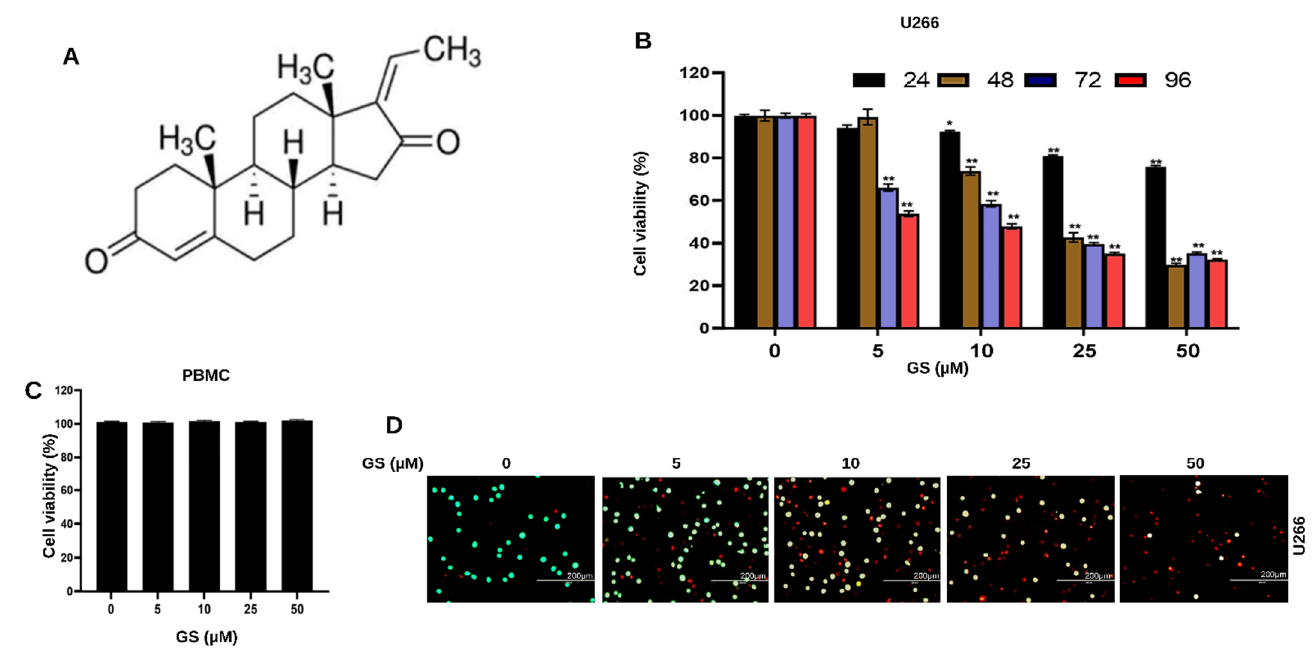
Figure 1. Anti-proliferative effects of GS on MM cells. ( A ) Chemical structure of Z-isomer of guggul- sterone (4,17(20)-pregnadiene-3,16-dione). GS inhibits the viability of ( B ) U266 in a concentration- dependent manner but does not inhibit the viability of ( C ) PBMCs (normal control cells) after treatment with 5, 10, 25, and 50 µ M of GS for 48 h. The graphs display the mean ± SD of three independent experiments with replicates. * p < 0.05, ** p < 0.001. ( D ) Cell viability assessment performed using live/dead cytotoxicity kit at 5, 10, 25, and 50 µ M GS treatment on U266 cells where green indicates live cells and red indicates non-viable cells (Scale bar, 200 µm).